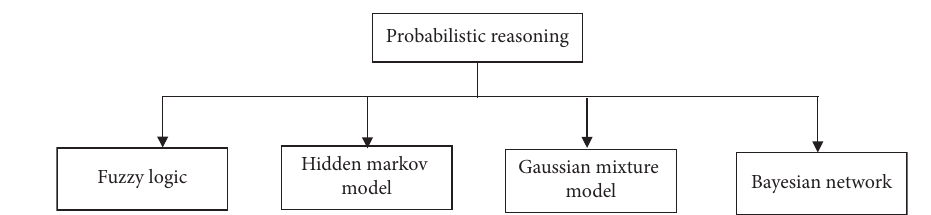
Figure 4: Subdivision of probabilistic reasoning models.